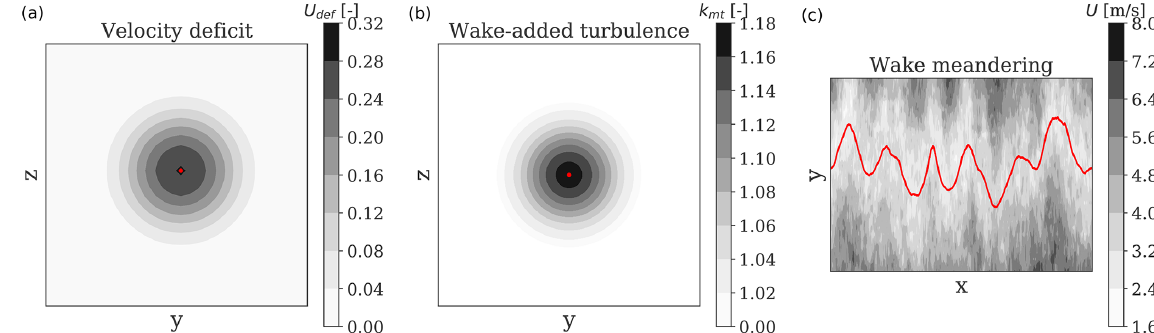
Figure 2. Qualitative representation of the three wake components predicted by the DWM model, including an axisymmetric quasi-steady velocity deficit, which is defined as the local wind speed U divided by the ambient wind speed ¯ U amb (a) ; a wake-added turbulence scaling factor, k mt (b) , that assumes zero values outside of the wake region; and the meandering of the quasi-steady wake deficit superposed on a random homogeneous turbulence field realization (c) . The red marker identifies the wake center position, and the solid red line identifies the wake center’s trajectory along the longitudinal x and lateral y coordinate. The wake also meanders in the vertical direction (not shown). The wake features are computed for an ambient inflow characterized by ¯ U amb = 6ms − 1 and a turbulence intensity of TI amb =